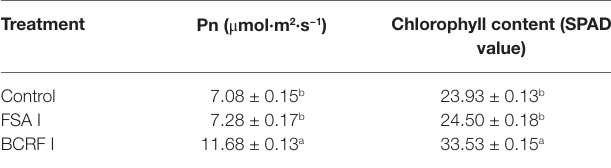
Different letters indicate statistically significant differences (p <